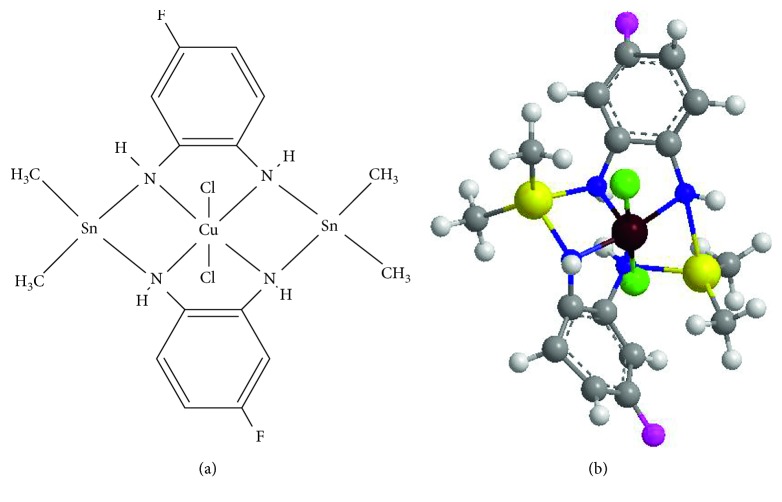
Proposed structure for heterobimetallic complex [Cu(C6H5N2F)2Sn2(CH3)4Cl2].